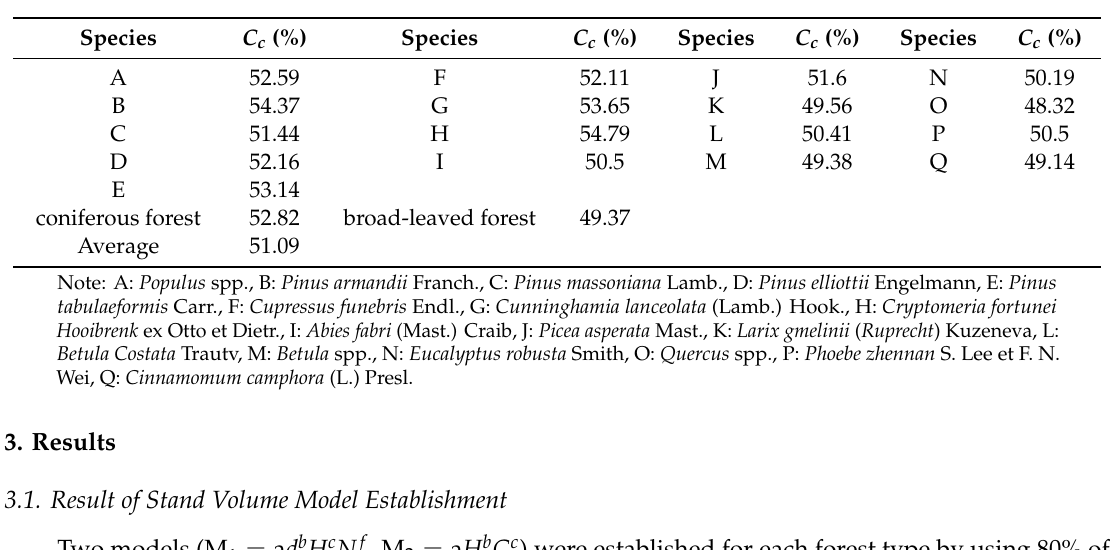
Table 3. Carbon content in stands weighted by aboveground biomass (AGB).